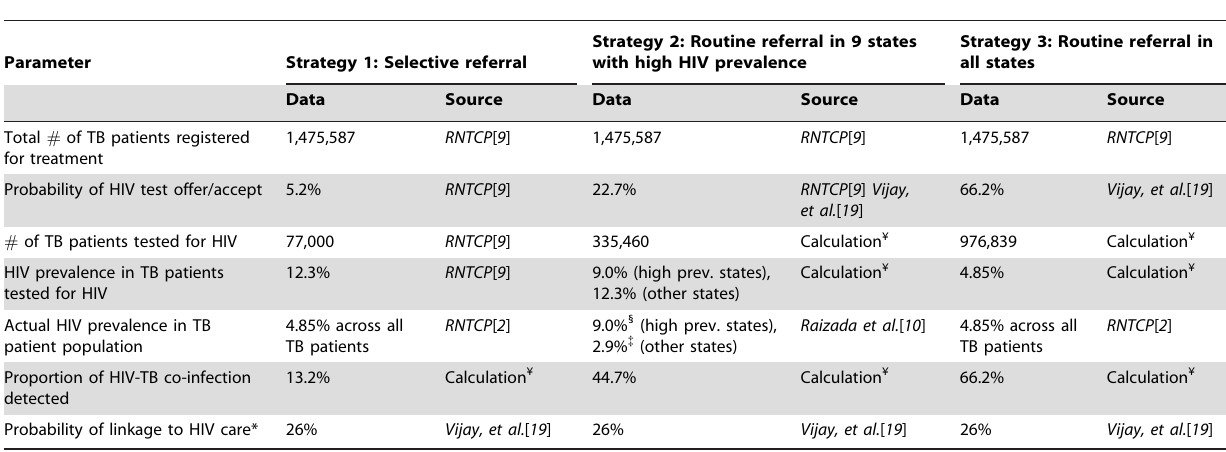
Table 3. Rates of HIV test offer and acceptance, proportion of HIV/TB co-infection detected, and linkage to HIV care, stratified by referral strategy, for TB patients in